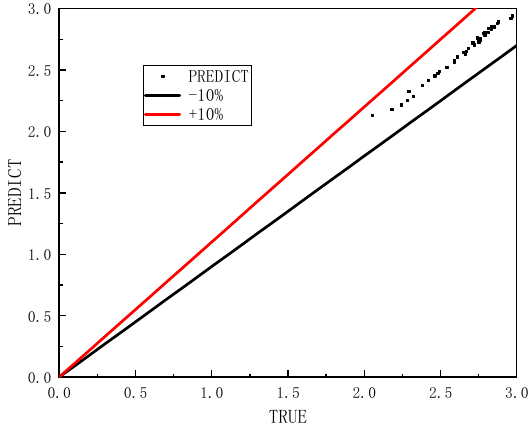
Figure 27. Comparison between predicted and calculated values (30°~60°).